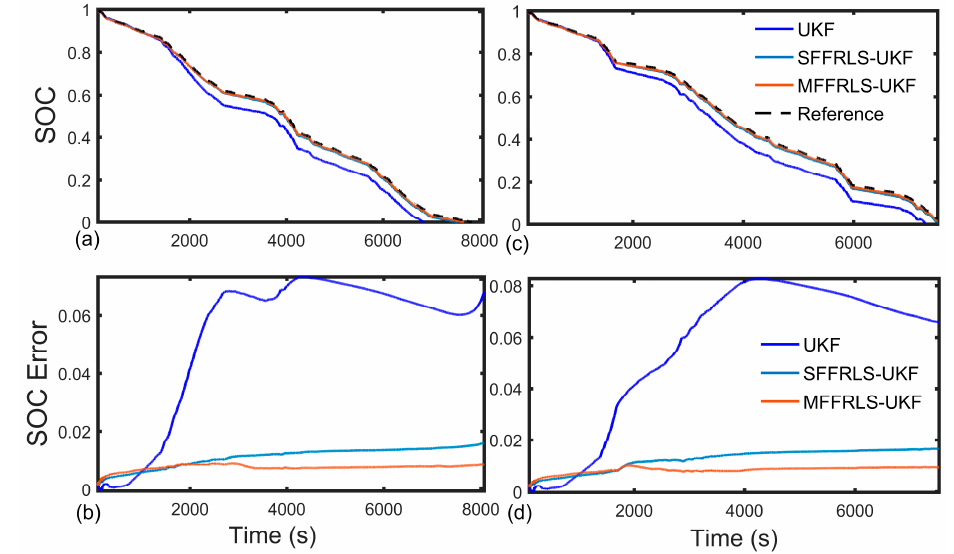
Figure 10. Current and temperature profile of two multiple cycles tests under changing temperature: ( a , b ) Multiple Cycle 1; ( c , d ) Multiple Cycle 2.